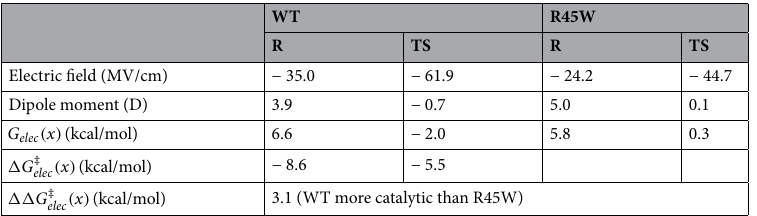
Table 2. The dipole moment of the reacting moiety and the magnitude of the electric field exerted by the enzymatic environment at the midpoint between the two reacting atoms (C of serotonin and N of lumiflavin) for the state of reactants (R) and for the transition state (TS). Both values are projected onto the C…N axis of the reacting moiety (presumed direction of electron flow). The value of the calculated free energy of electrostatics ( G elec ( x ) ) is also given, as well as the difference in this quantity between TS and R. All values are given for WT and for R45W and the final difference in � G elec ( x ) between the two is